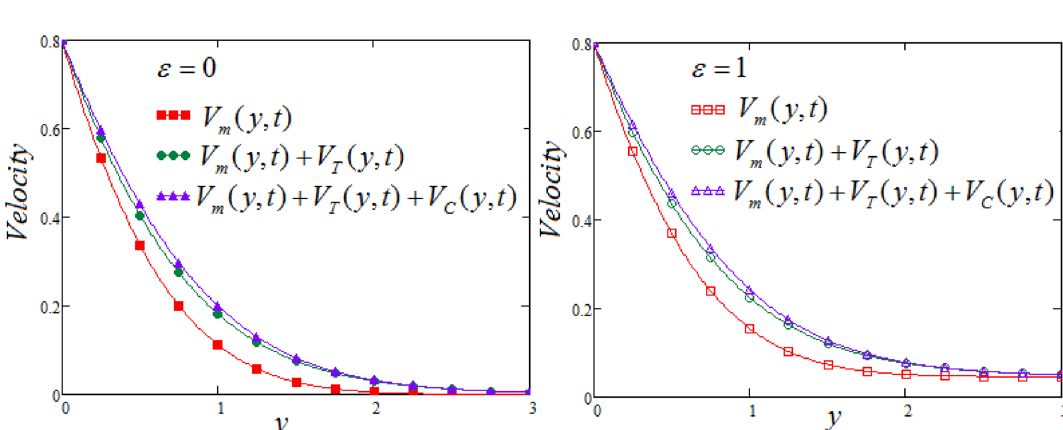
Figure 9. Representation of fluid velocity components against y at t = 0.8 with Pr eff = 4.5, (cid:31) 1 = 0.7, ℘ =